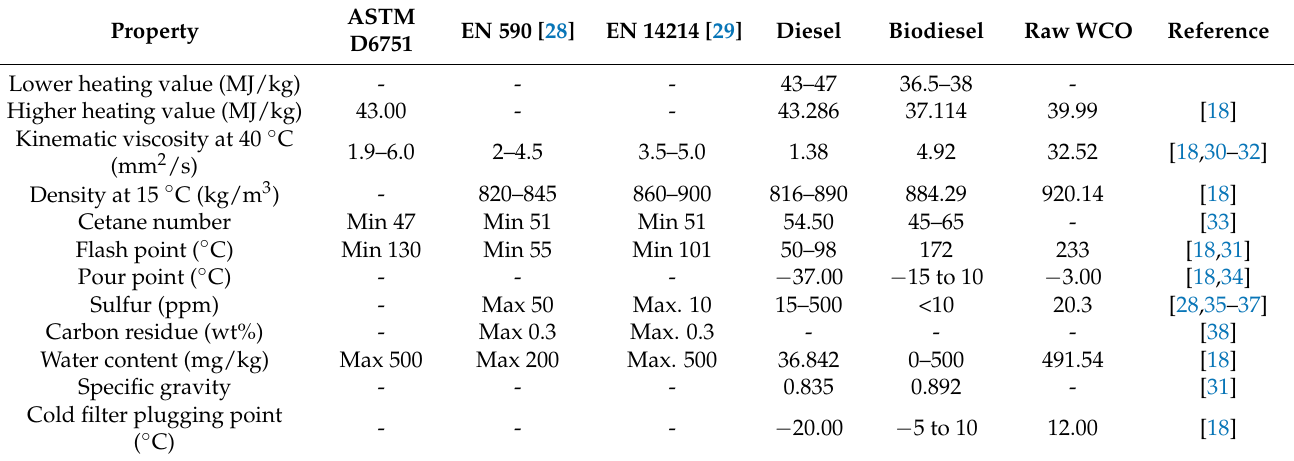
Table 1. Physicochemical properties of different fuels.